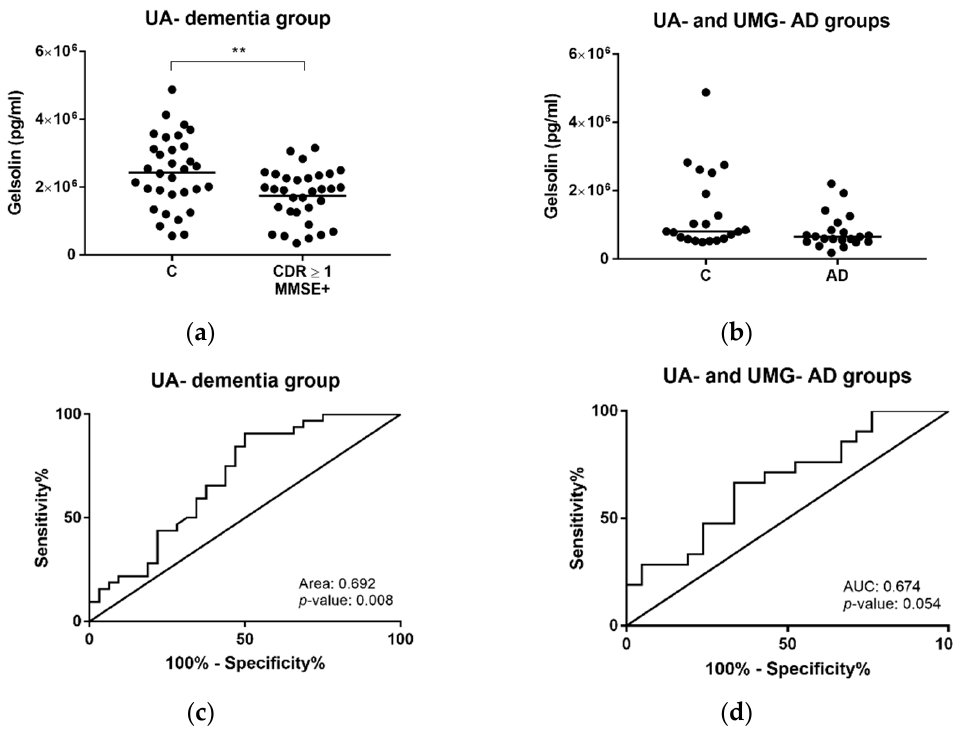
Figure 6 . Gelsolin concentrations in dementia and AD cases determined by ELISA. Gelsolin levels were assessed through ELISA assays in serum-derived exosomes from controls (CDR = 0 and MMSE–) and individuals with dementia (CDR ≥ 1 and MMSE+) from UA-dementia group ( a ), and from AD clinically diagnosed cases and controls from UA- and UMG-groups ( b ). ROC curves were obtained for the control and dementia group (UA-dementia group) ( c ) and controls and AD cases from UA- and UMG-groups ( d ). Each point represents the gelsolin mean concentration obtained for each individual and the solid horizontal line shows median of the groups. Abbreviations: AD, Alzheimer’s disease; A.U., arbitrary units; AUC, area under the curve; C, controls; CDR, clinical dementia rating; ELISA, enzyme-linked immunosorbent assay, MMSE, Mini-Mental State Examination; ROC, receiver operating curve. ** p ≤ 0.01.